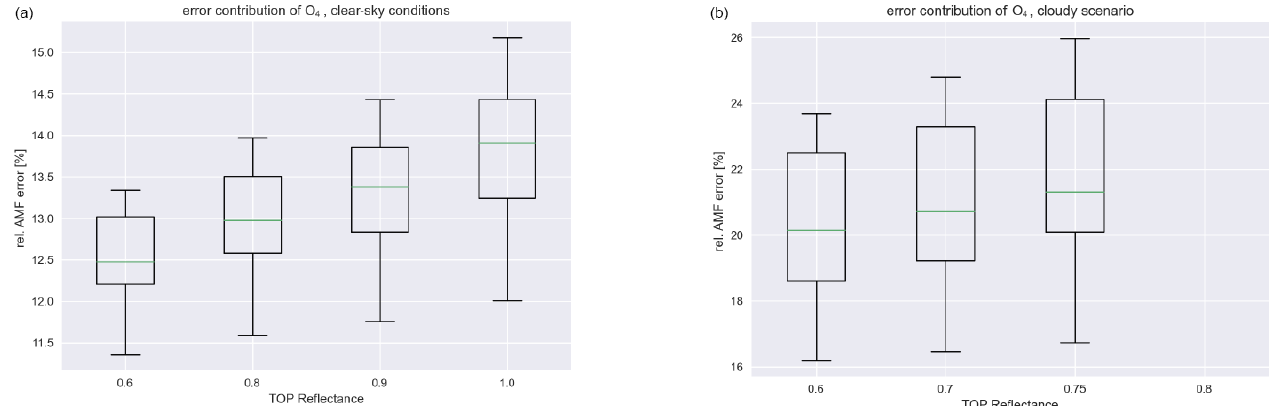
Figure 2. Contribution of the O 4 uncertainty to the overall AMF error for different reflectances. (a) Clear-sky scenario (high-O 4 AMF). (b) Cloudy scenarios (low-O 4